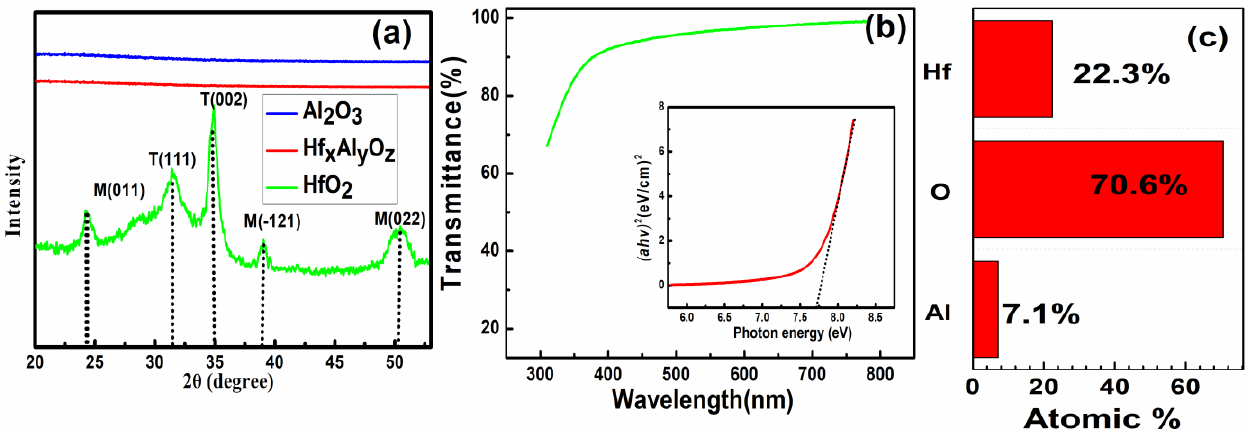
Figure 2. ( a ) GAXRD pattern of Al 2 O 3 film, HfO 2 film, and Hf x Al y O z nanolaminates; ( b ) the transmittance spectra of the Hf x Al y O z nanolaminate thin films; ( c ) atomic % diagram for Hf x Al y O z thin film.